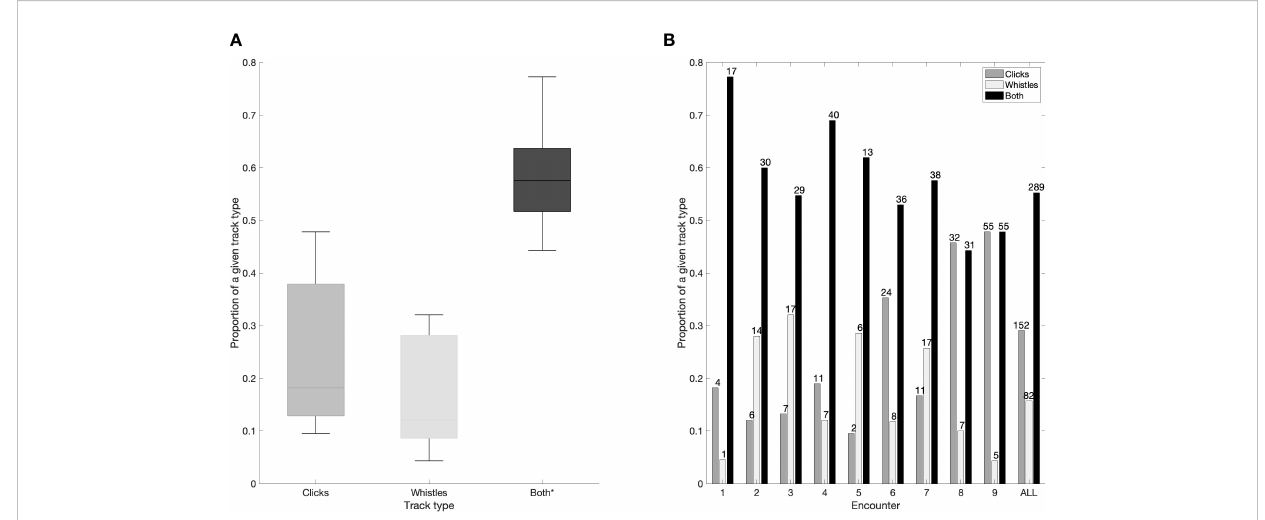
FIGURE 1 Proportion of a given track type (Clicks/Whistles/Both) in all encounters collectively (A) and in each individual encounter (B) . On each box in (A) the central line indicates the median, the bottom and top edges of the box indicate 25th and 75th percentiles, respectively. The whiskers in (A) extend to most extreme data points not considered outliers. Statistically signi fi cant results are denoted with an asterisk. The numbers above each bar in (B) denote the number of a given track type in that